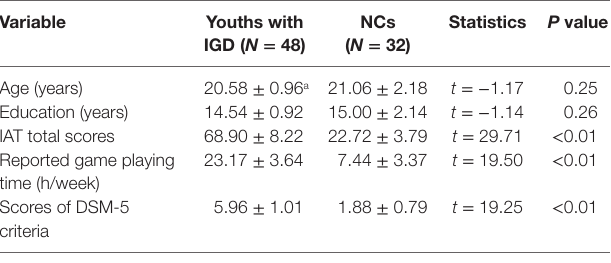
TaBle 1 | Demographic characteristics of youths with IGD and NCs.